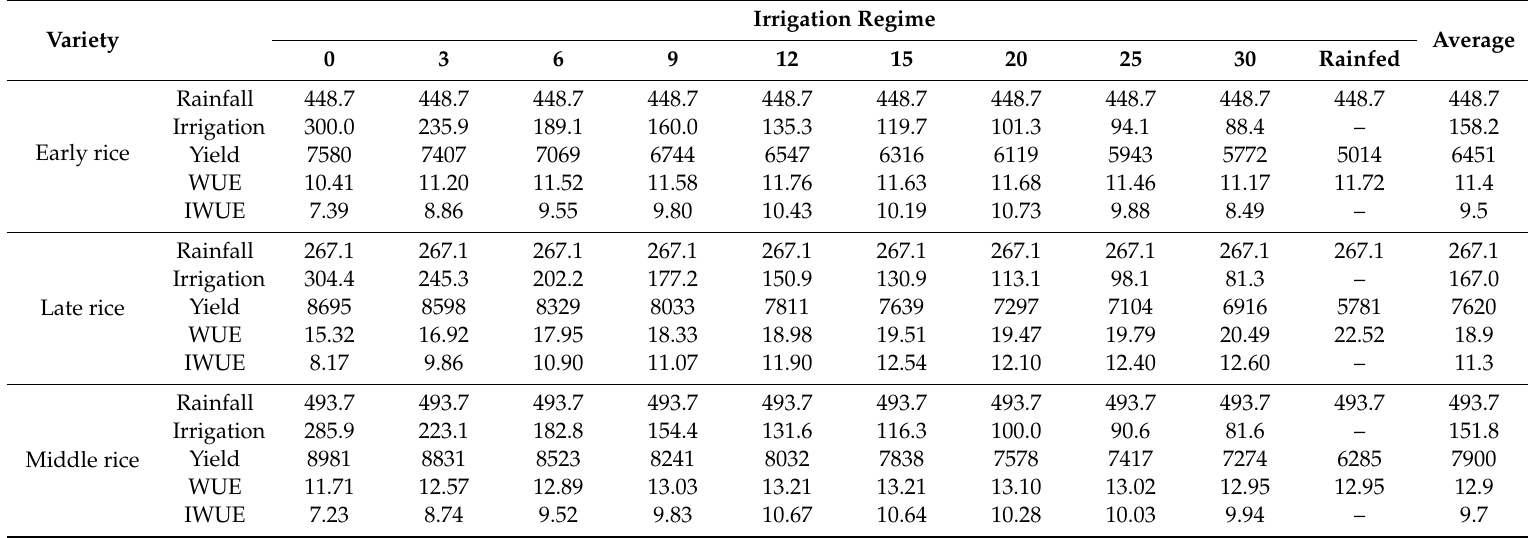
Table 6. Rainfall amount (mm), irrigation regime (amount of irrigation application for certain days after the paddy water layer disappeared, mm), rice grain yield 1981–2015 in the study region.